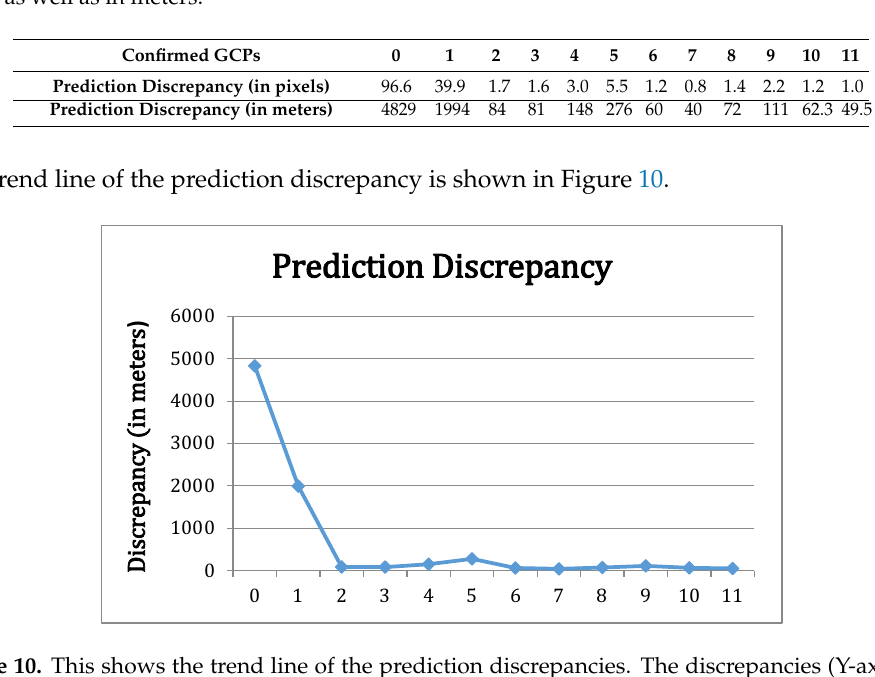
Table 2. This table shows all the prediction discrepancies logged. The discrepancies are measured in pixels as well as in meters.